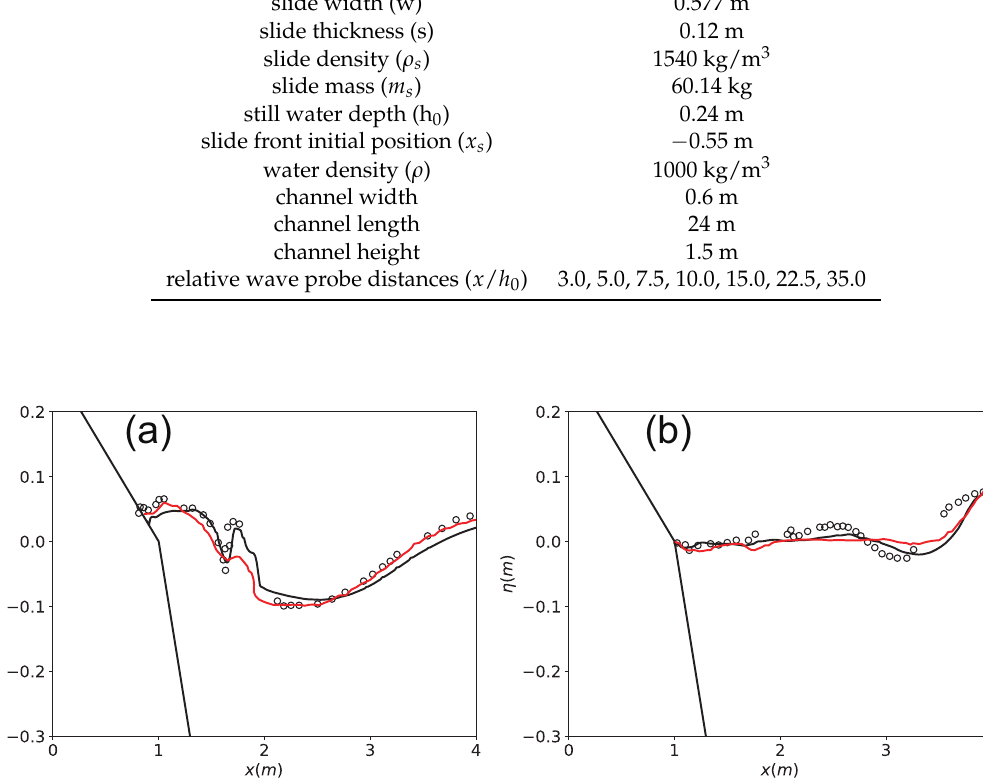
Figure 2. Water surface elevation η at different time. ( a ) t = 1.5 s; ( b ) t = 3 s: experimental data (circle), current solution (black), and Nasa-vof2D results (red) of Heinrich